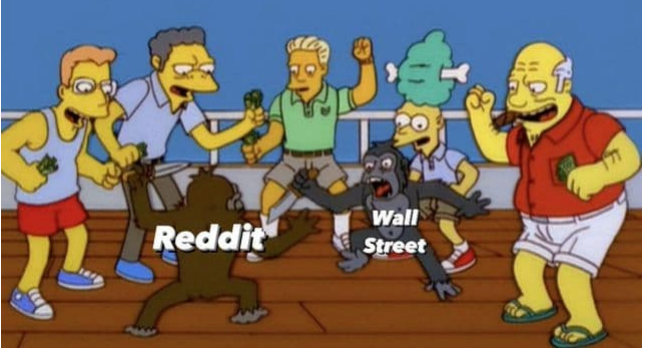
Figure A1. A meme used to describe meme investors’ short squeezing. https://www.menshealth.